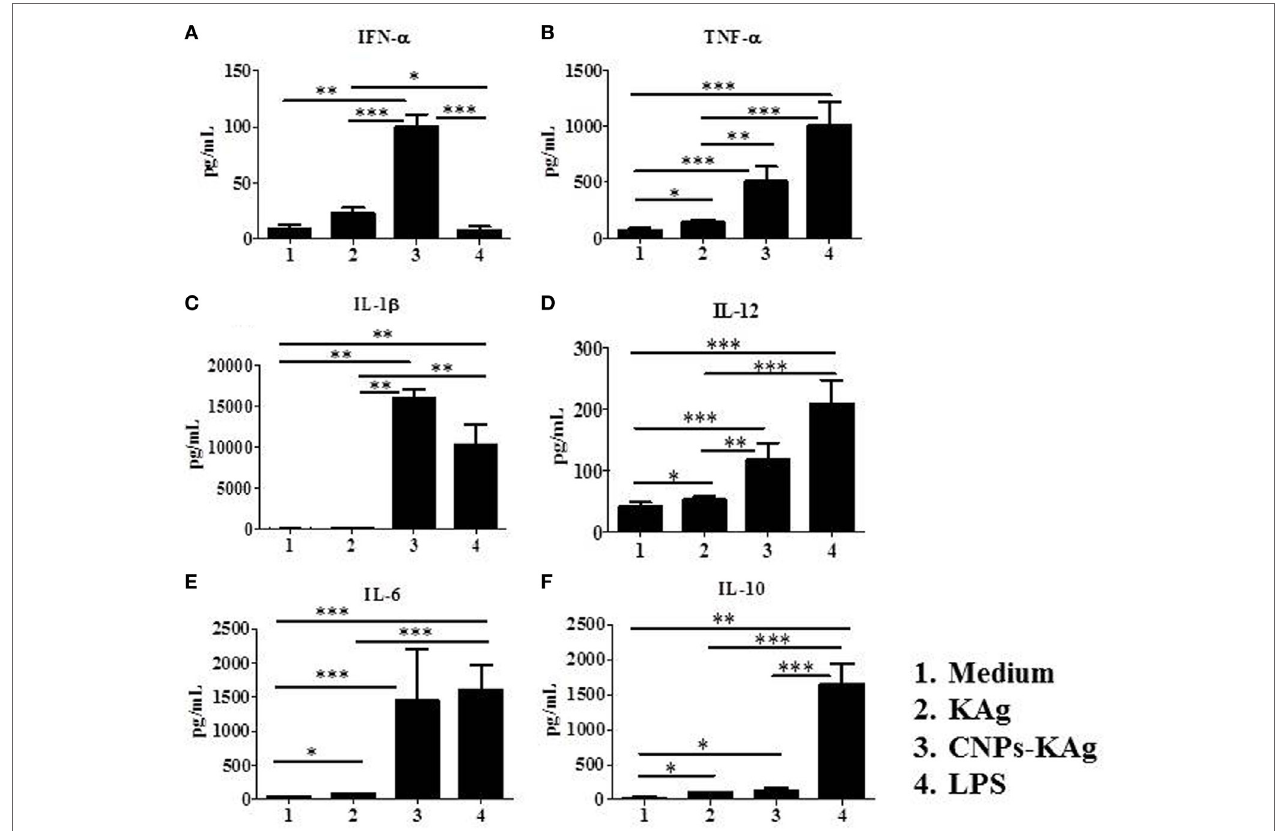
FigUre 2 | Production of innate, pro-inflammatory and T helper 1 cytokines by porcine MoDCs treated for 48 h with medium, KAg, chitosan nanoparticles (CNPs)-KAg or LPS control. Levels of cytokines (a) IFN- α , (B) TNF- α , (c) interleukin (IL)-1 β , (D) IL-12, (e) IL-6, and (F) IL-10 were estimated in stimulated cell culture supernatant by ELISA. Data represent mean value of seven pig-derived DCs ± SEM. Statistical analysis between two groups was carried out using Mann–Whitney test. Asterisk refers to statistical significant difference between the indicated two pig groups. * p < 0.05, ** p < 0.01, and *** p <